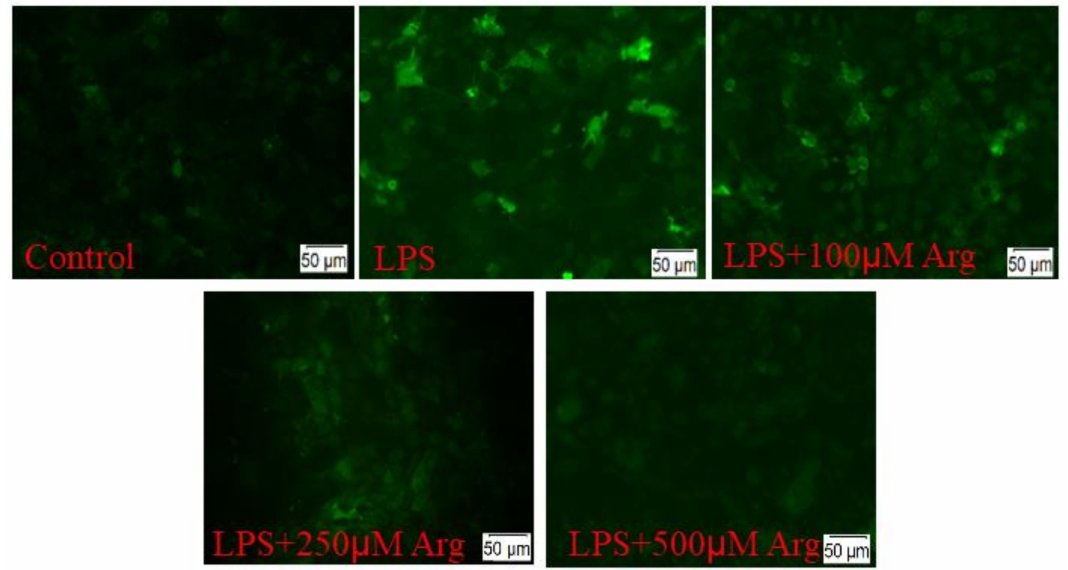
Figure 5. L-Arginine supplementation (Arg) reduced LPS-triggered reactive oxygen species (ROS) in IPEC-J2 cells. Three replications were performed for each experiment.